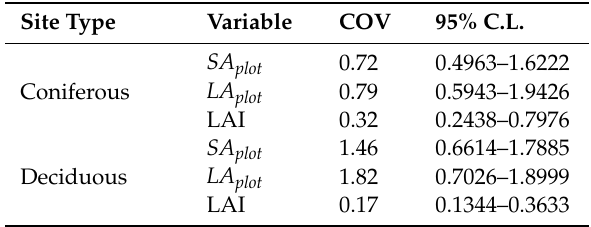
Table 6. Coe ffi cient of variation (COV) results for the coniferous and deciduous stands’ SA plot , LA plot and LAI with their 95% confidence intervals (95%